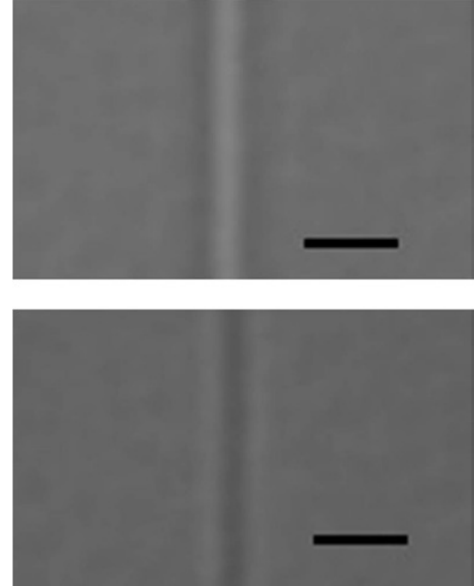
Figure 2: Defocused images of an immersed silk double cylinder with p - (top) and s -polarized (bottom) illumination. The observed inversion in the contrast demonstrates that, in this instance, n between n and n . The scale bar is 5 μ m. p s